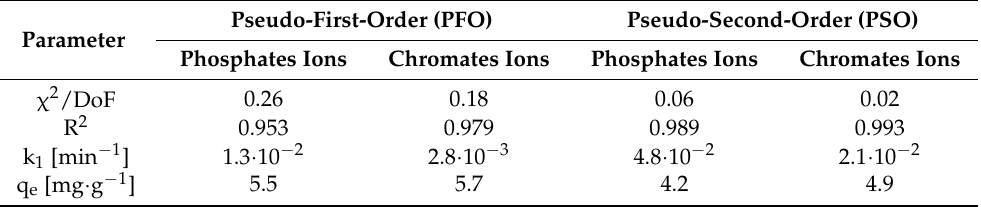
Table 9. Kinetic PSO and PFO model constants and correlation coefficients for the sorption systems.